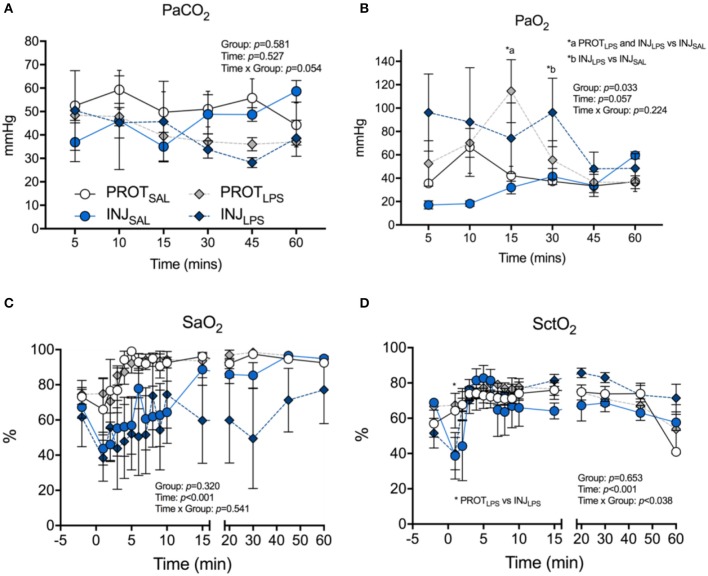
Effects of ventilation strategy and LPS exposure on blood gases and oxygen saturation. Changes in partial pressure of CO2 (PaCO2) (A), and partial pressure of O2 (PaO2) (B) in arterial blood, arterial oxygen saturation (SaO2) (C), and cerebral tissue O2 saturation (SctO2) (D) in the PROTSAL, INJSAL, PROTLPS and INJLPS lambs. PROTSAL, N = 5; PROTLPS, N = 6; INJSAL, N = 6; and INJLPS, N = 5. *p < 0.05.